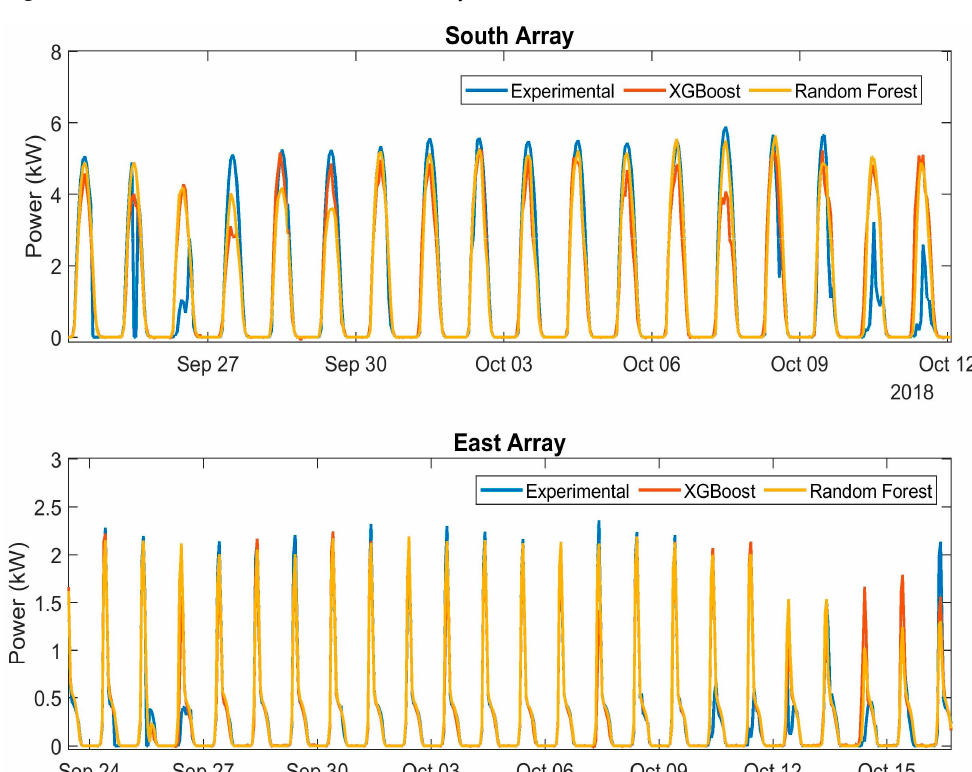
Figure 7. Hourly power forecasted for south and west arrays for the best performance cases.